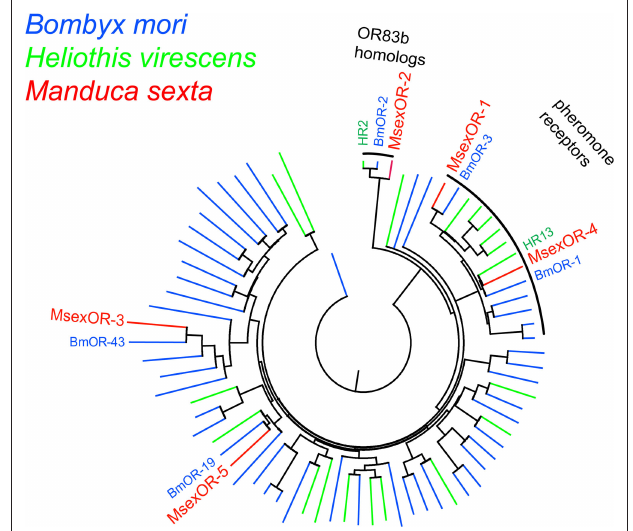
Figure 1 | Tissue-specific expression of identified Or-coding genes. Reverse transcriptase (RT)-PCR was performed using gene-specific primers for each receptor type and cDNAs of male (left) and female (middle) M. sexta antennae (control using water instead of cDNA, right). PCR products were visualized after gel electrophoresis using ethidium bromide staining. All bands were of the expected size, based on primer design. MsexOR-4 and MsexOR-1 showed male-specific expression, while MsexOR-5 and MsexOR-6 could only be detected in cDNA of female antennae.